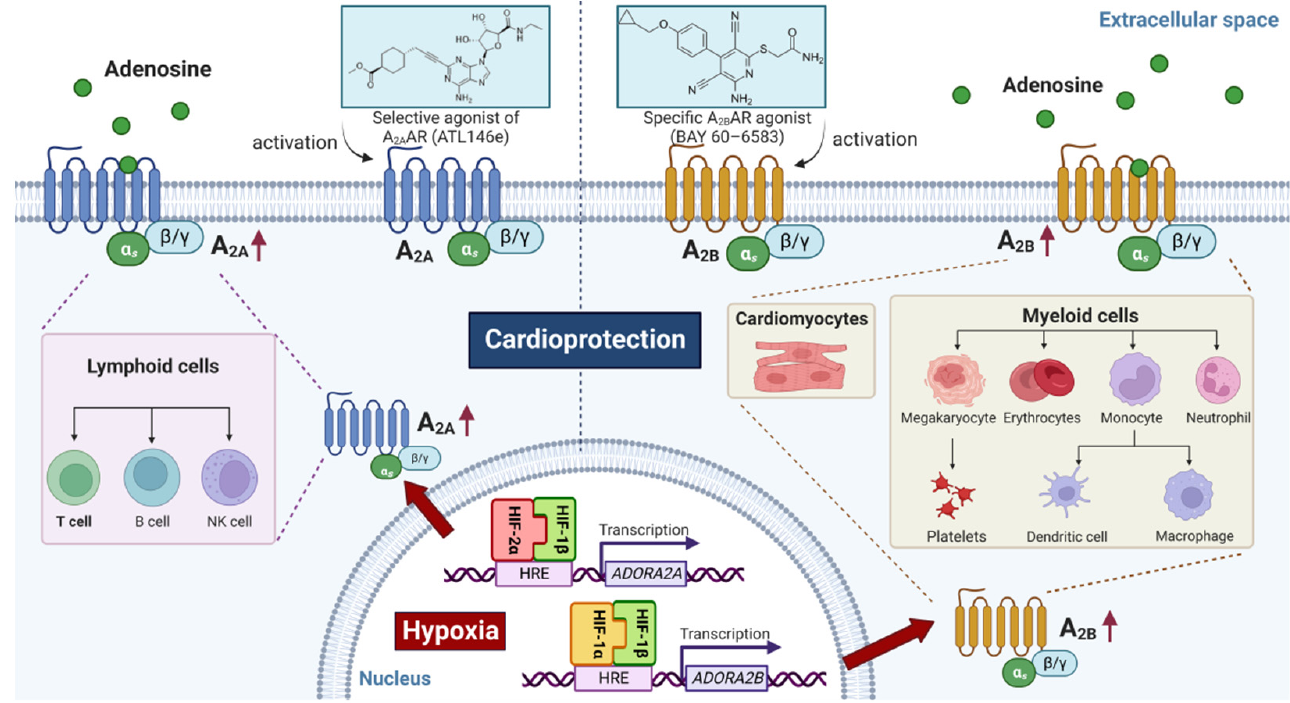
Figure 2. HIF protects against myocardial ischemia-reperfusion injury through the modulation of adenosine receptor signaling events. Adenosine receptors belong to the G protein-coupled receptor family and are composed of different subunits: the Gs alpha subunits (G α s) and the beta-gamma subunit complex (G β / γ ). The adenosine receptors Adora2a and Adora2b have been identified as target genes of HIF. Under hypoxic conditions, Adora2a and Adora2b are transcriptionally induced by HIF2A and HIF1A, respectively. Activation of these receptors with their specific agonists showed reduced infarct size in murine models of myocardial ischemia-reperfusion injury, suggesting their role in mediating the cardioprotective effects of HIF. The cardioprotection provided is associated with the activation of Adora2a signaling on lymphocytes and Adora2b signaling on myeloid cells and cardiomyocytes. The red arrowhead denotes upregulation. A2 A : Adenosine A2a Receptor. A2 B : Adenosine A2b Receptor.